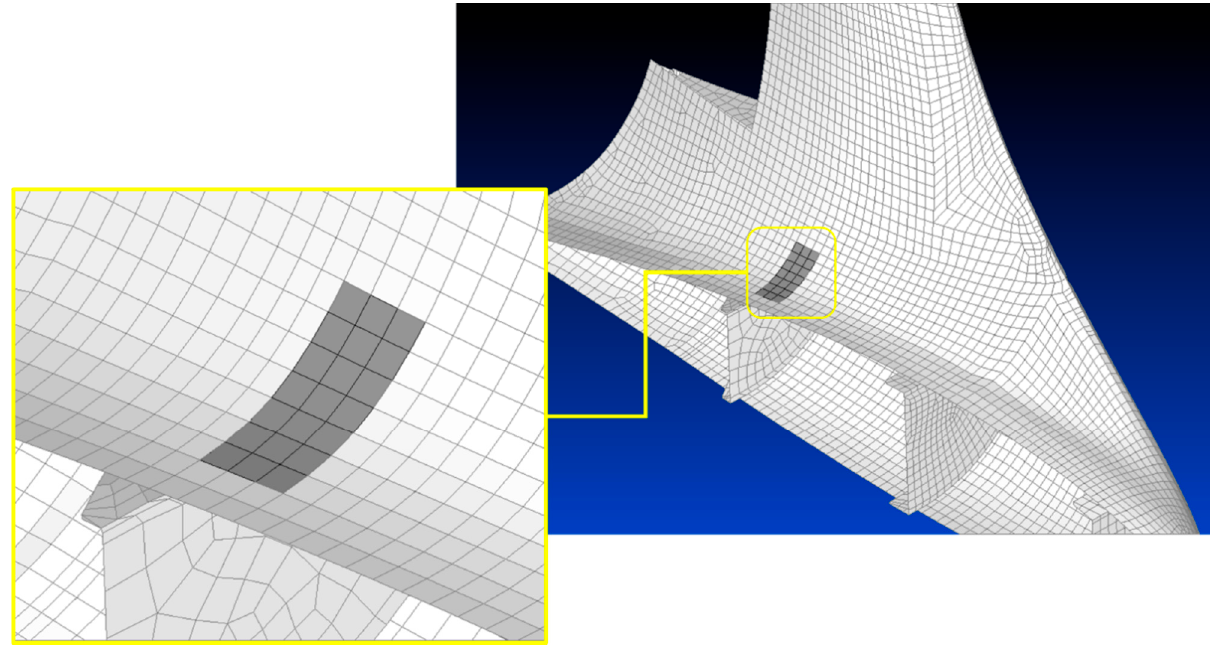
Figure 5. Zone of the model considered for the parametric refinement.